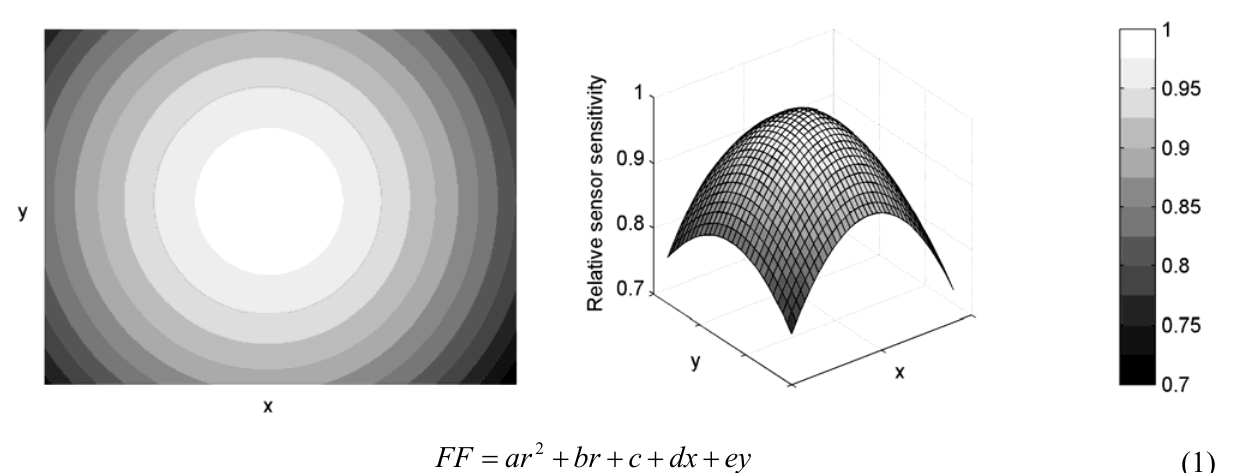
Figure 3. The flat-field calibration image. A large difference of around 25% in sensitivity is seen between the image center and the